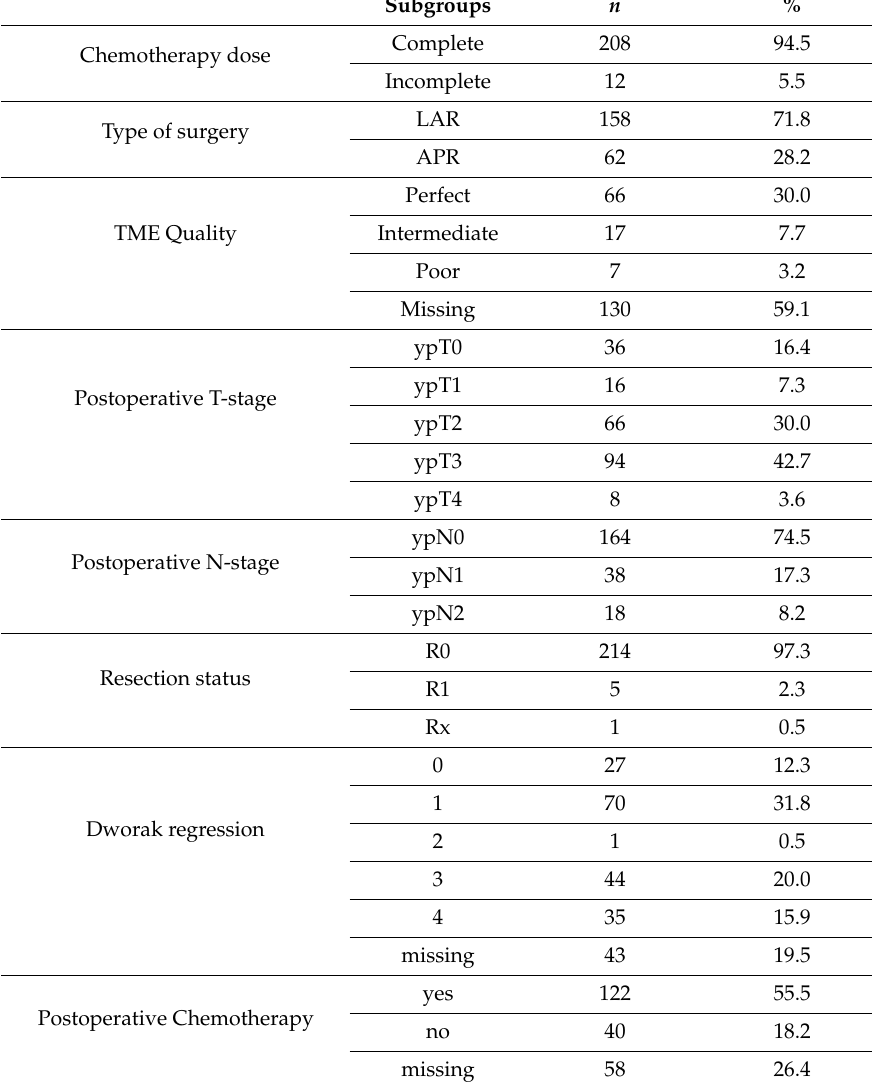
Table 2. Treatment-related parameters.